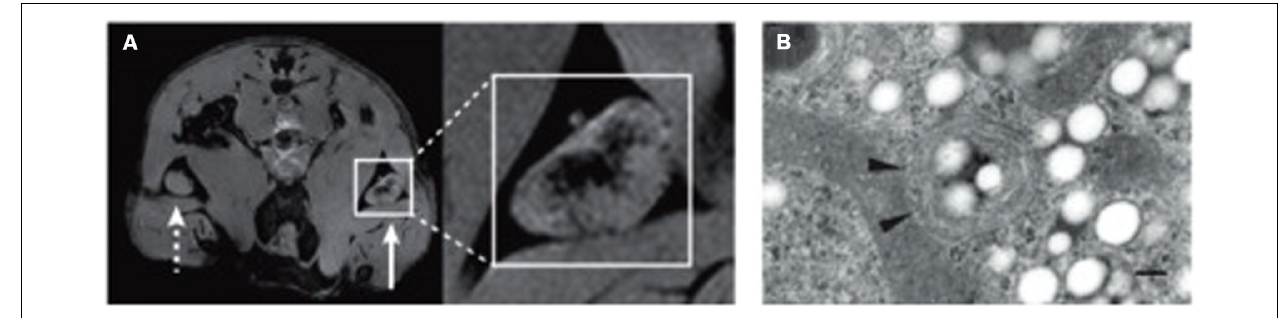
as magnetovaccination, the hypointense DCs migrate into the medulla of the draining popliteal lymph node. (B) An electron micrograph of a perfluorocarbon (PFC)-labeled DC is shown. Numerous bright spots (PFC droplets) are observed inside the cell. Particles appear as smooth spheroids (Ogawa etal., 1990). Arrowheads indicate vesicles.The scale bar represents 200 nm. Adapted from Ahrens and Bulte (2013), reproduced with